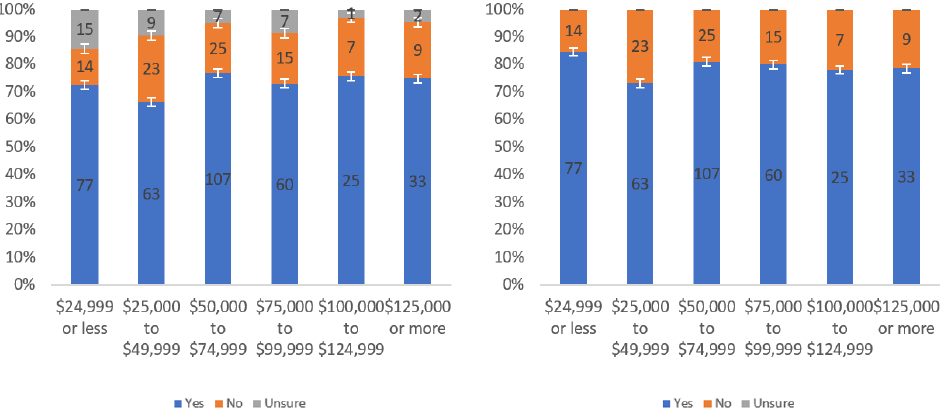
Figure 7. Responses regarding label helpfulness by income level including ( left ) and excluding ( right ) unsure responses.